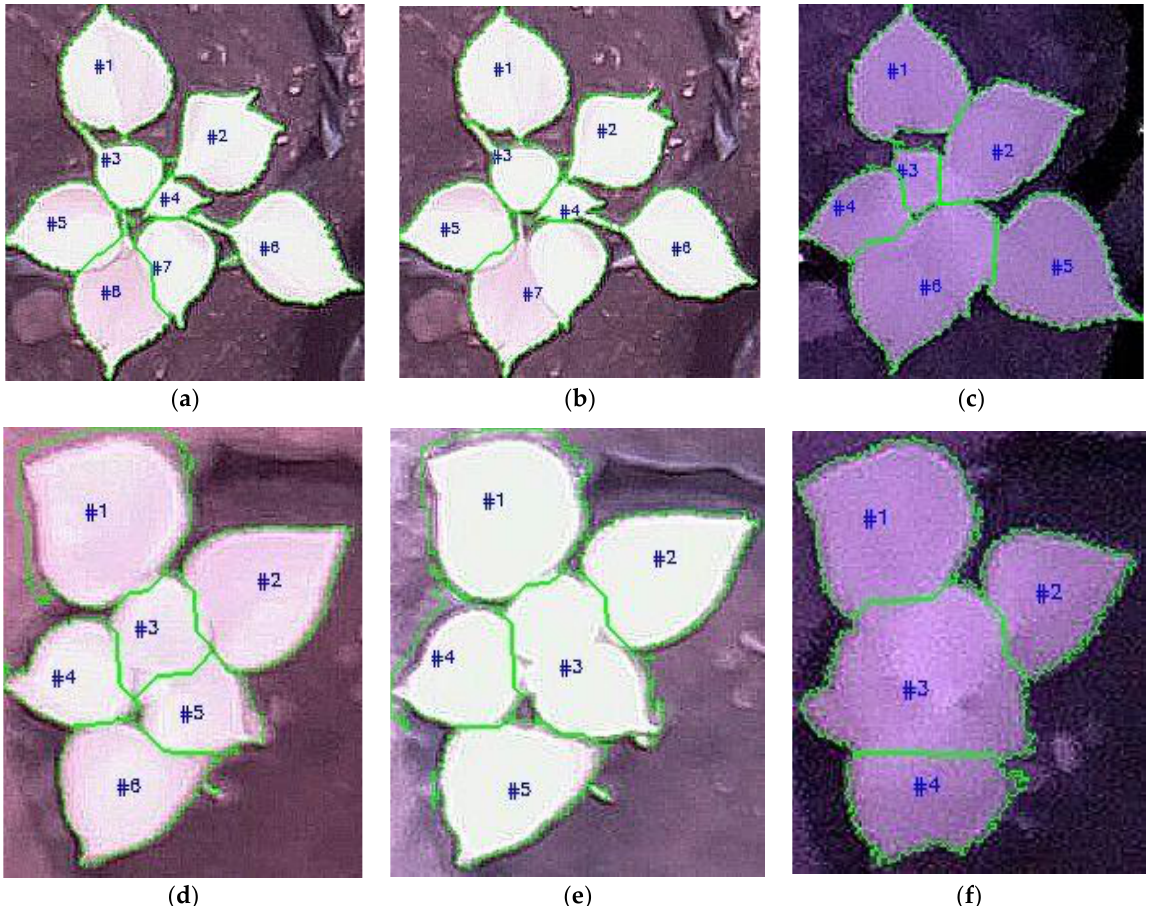
Figure 19. Leaf counting results using NoIR camera: ( a , d ) without miscounting errors; ( b , c , e , f ) with miscounting errors. The evaluation results of DiC and ABS_DiC are given in Figures 20 and 21, respec- tively. In the figures, the performances of leaf counting in the day and night images are compared using seven plants: Plant-A to Plant-G. The Plant-av represents the average value of the seven plants.